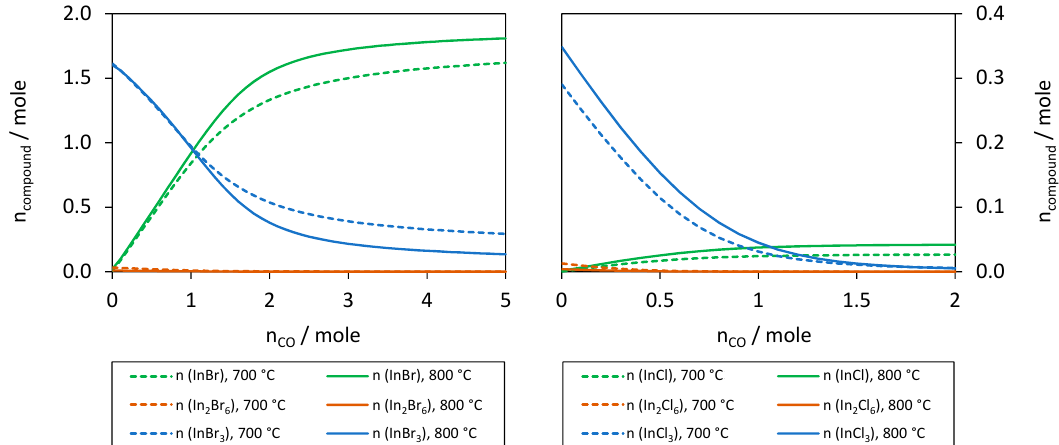
Figure 8. Proportion of formed indium halides by HBr ( left ) and HCl ( right ) depending on the amount of CO.